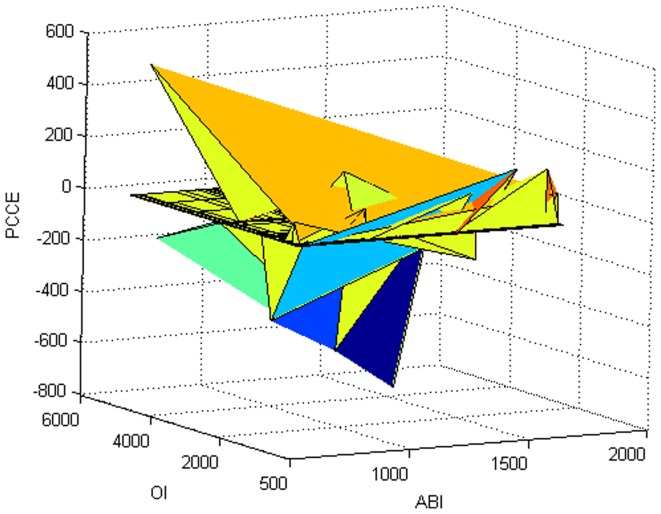
Variance squares.